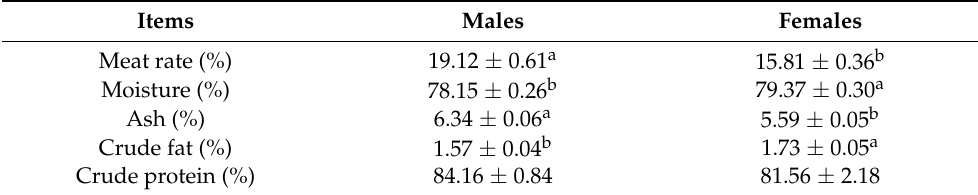
Table 1. The meat rate and content of conventional nutrients in the muscles of C. quadricarinatus with different sexes (dry weight; N =